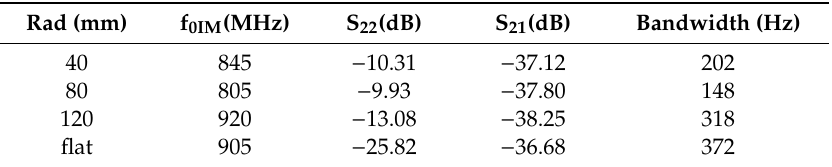
Table 3. Antenna characteristics under bending conditions.